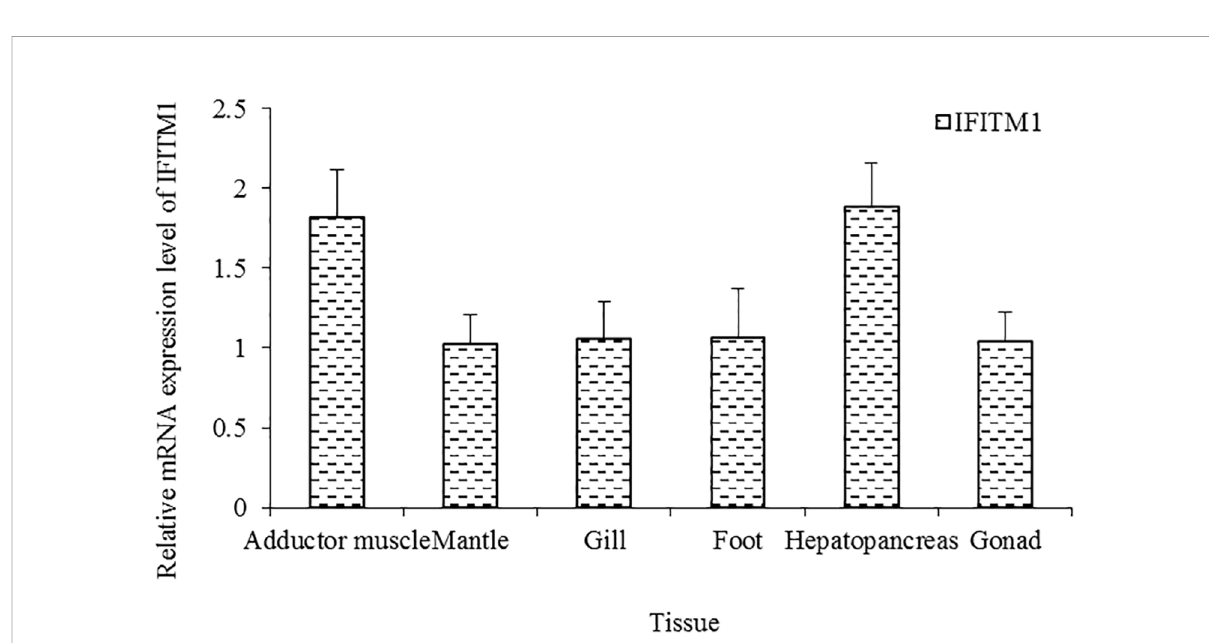
FIGURE 6 Expression of the IFITM1 gene in various tissues of Cyclina sinensis